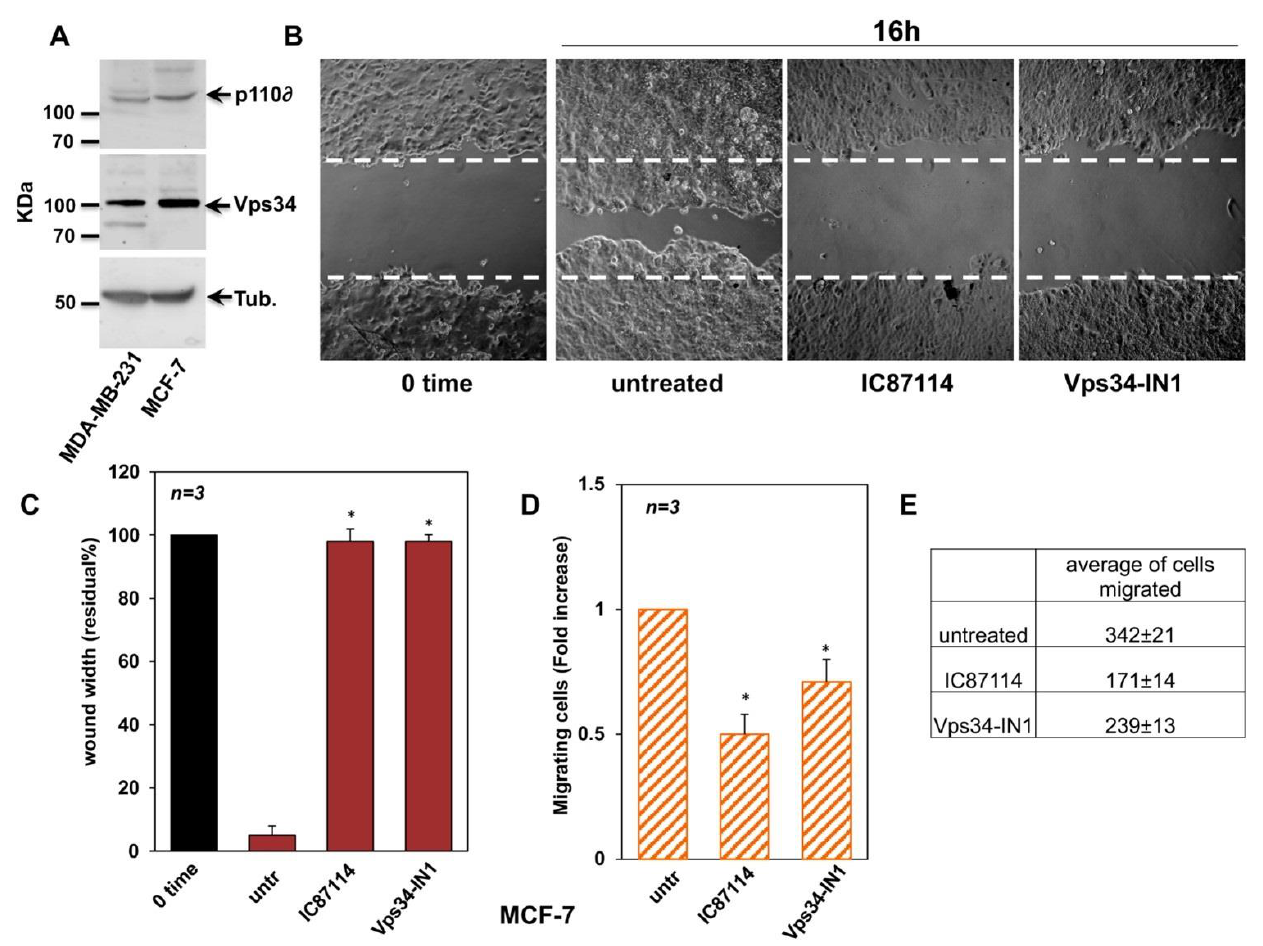
Figure 2. Effects of IC87114 and Vps34-IN1 on MCF-7 cell migration. ( A ) Expression of p110 δ and VPs34 in total cell lysates, as assessed by immunoblotting (50 mg/lane). ( B ) Cell monolayers were wounded, and untreated or treated for the indicated times with the PI3K p110 δ -selective inhibitor, IC87114, and Vps34-selective inhibitor, Vps34-IN1. Phase-contrast images are representative of three different experiments. ( C ) The wound area was measured using Image J Software, and data are presented as residual % in wound width over the control (0 time). ( D ) A migration assay was performed using Boyden’s chambers as reported in the methods section and expressed as fold change over the basal level (untreated cells). ( E ) The average number of MCF-7 cells that migrated after 6 h in the absence or presence of the inhibitors is shown. The starting number of MCF-7 cells was 30,000 cells for all experimental points, as reported and detailed in the materials and methods section. ( B – D ) Data from three different experiments were collected and analysed. Means and SEMs are shown. n represents the number of experiments. * p < 0.05 for the indicated experimental points versus the corresponding untreated control.